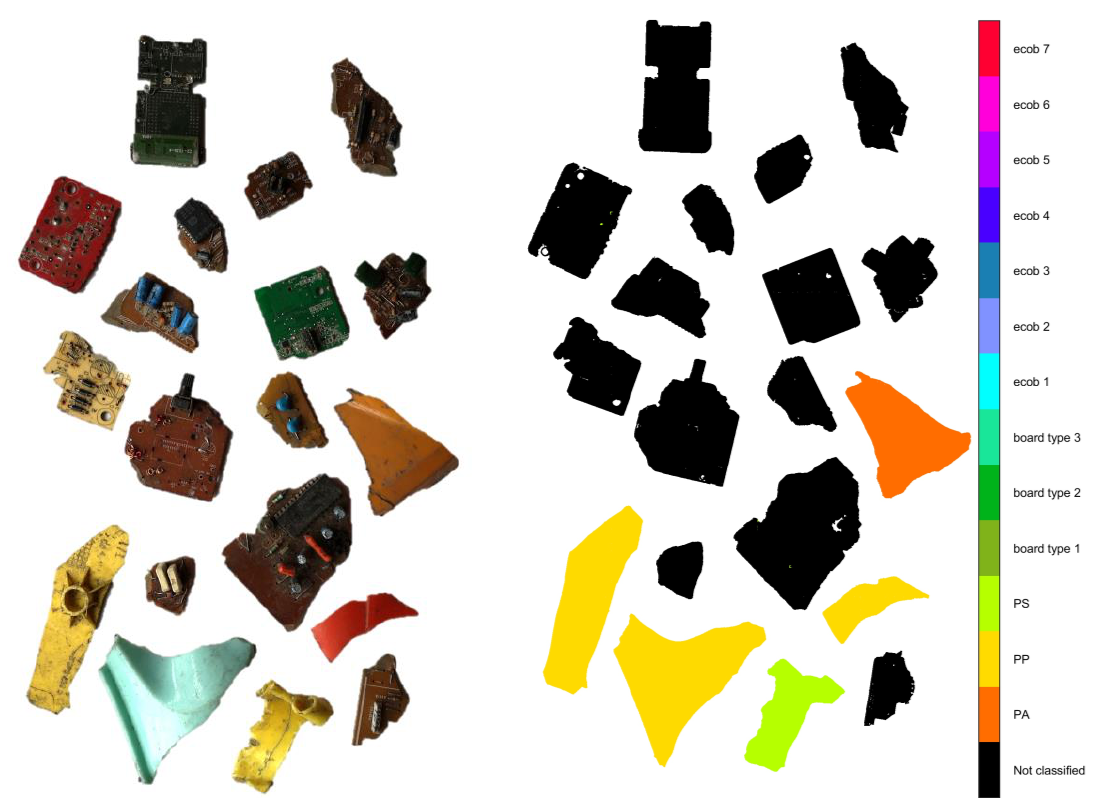
Figure 12. Example of result of classification (after step 1) of plastic objects by checking average spectra for each cluster.